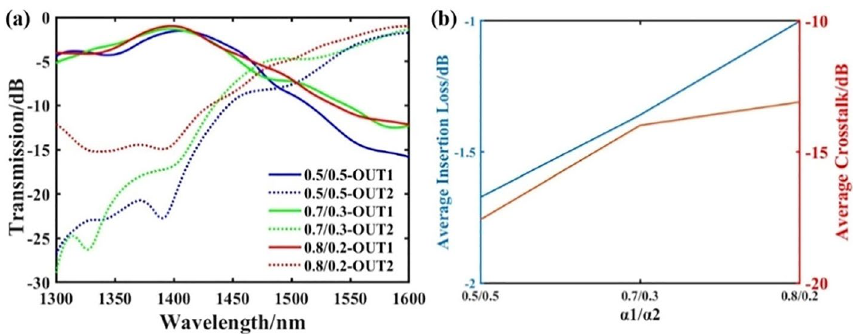
Figure 4. The effect of different weights changes on device performance. ( a ) The transmittance spectrum of the waveguide crossing under different weights. ( b ) The average insertion loss and crosstalk of the two target channels under different weights.